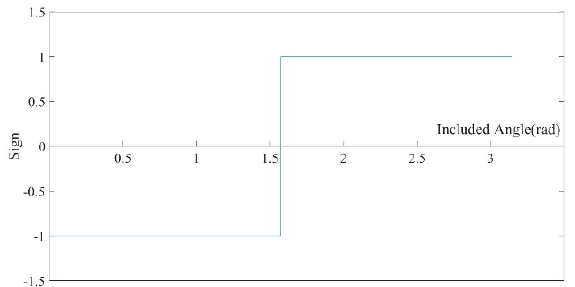
Figure 7. The plot of the sign S varying with the angle ɑ between vector n dis and line of sight V v ; at π = , the sign of TSDF is the angle 2